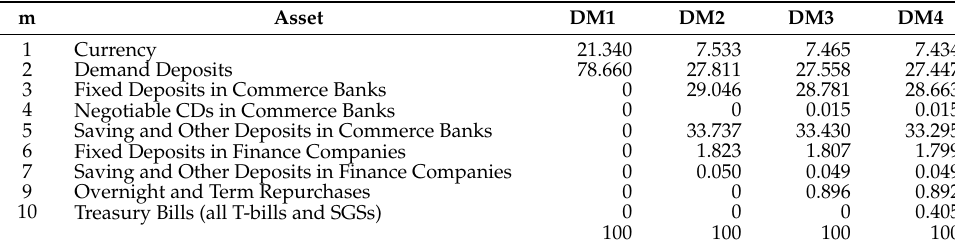
Table 4. Growth-rate Weights in the Last 12 Months (Apr 2020–Mar 2021), Percentages.